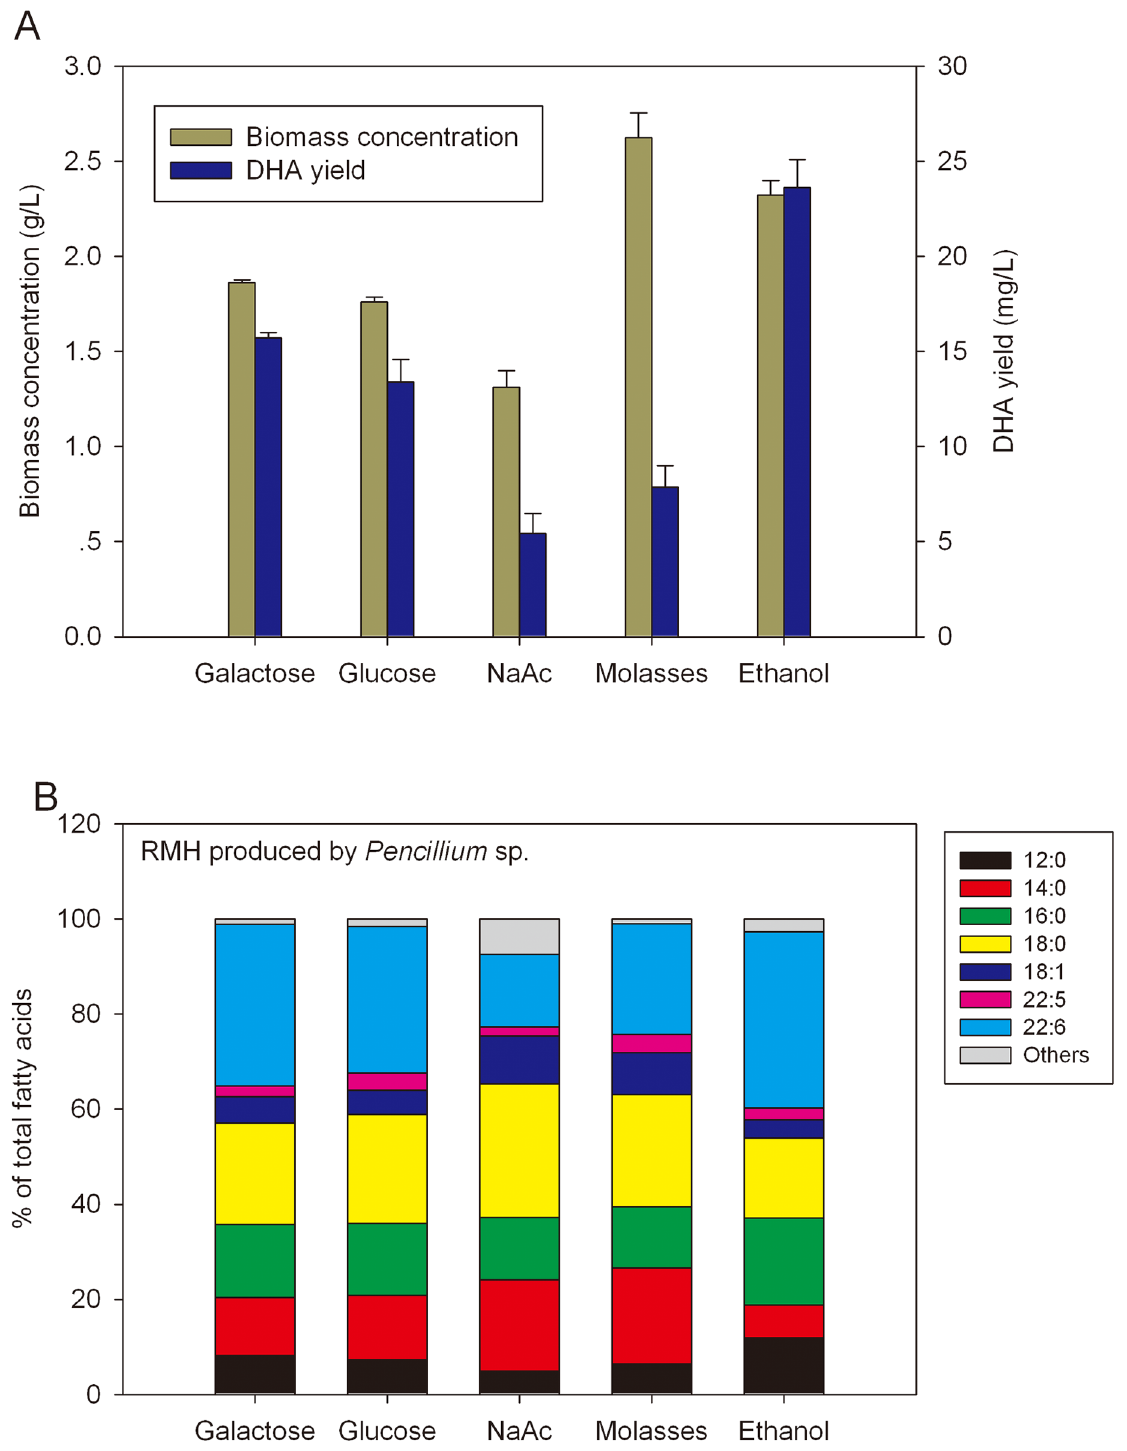
Fig 8. Biomass and lipid production by C . cohnii grown on RMH supplemented with different carbon sources. ( A ) Effect of supplemented carbon sources on biomass concentration and DHA yield of C . cohnii grown on basal meal hydrolysate. Data are means of three replicates, and error bars show standard deviation; ( B ) Fatty acid composition of C . cohnii grown on the Penicillium sp.-produced RMH supplemented with different carbon sources.